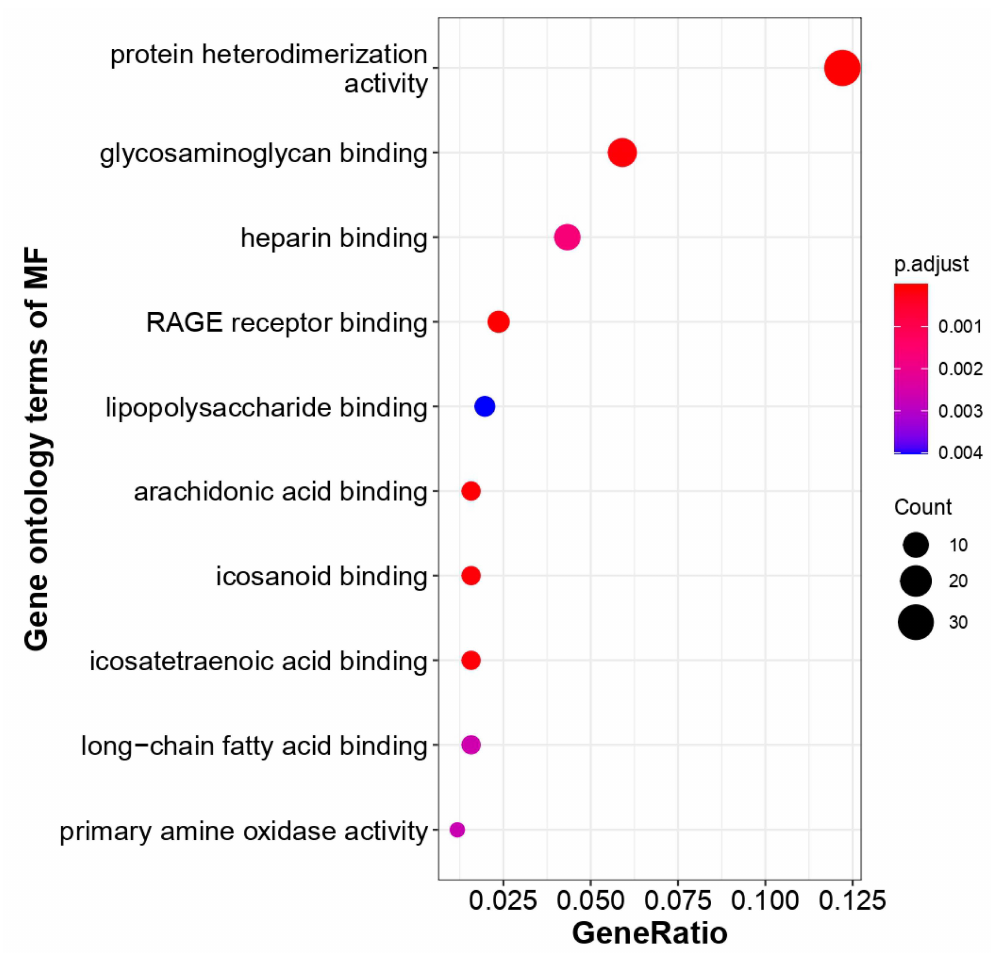
Figure 6. COVID-19-associated unique genes and their enriched molecular function. These unique genes’ fall in each GO molecular function term is directly proportional to the count ball size. The balls are color-shaded according to the significant enrichment level (log2FC cutoff ≥ 1, p -value cutoff